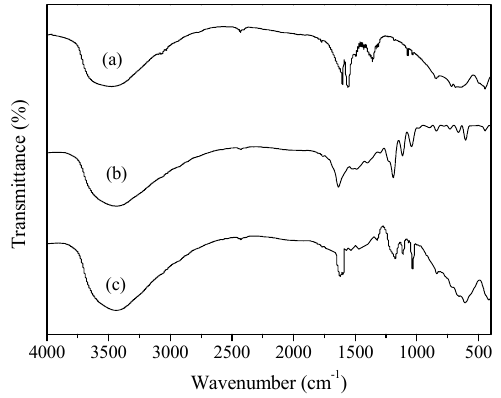
Figure 1. FTIR spectra of ( a ) LDH-[C 6 H 5 COO] (layered-double hydroxides), ( b ) Cr(SO 3 -salphen), ( c ) LDH-[Cr(SO 3 -salphen)].